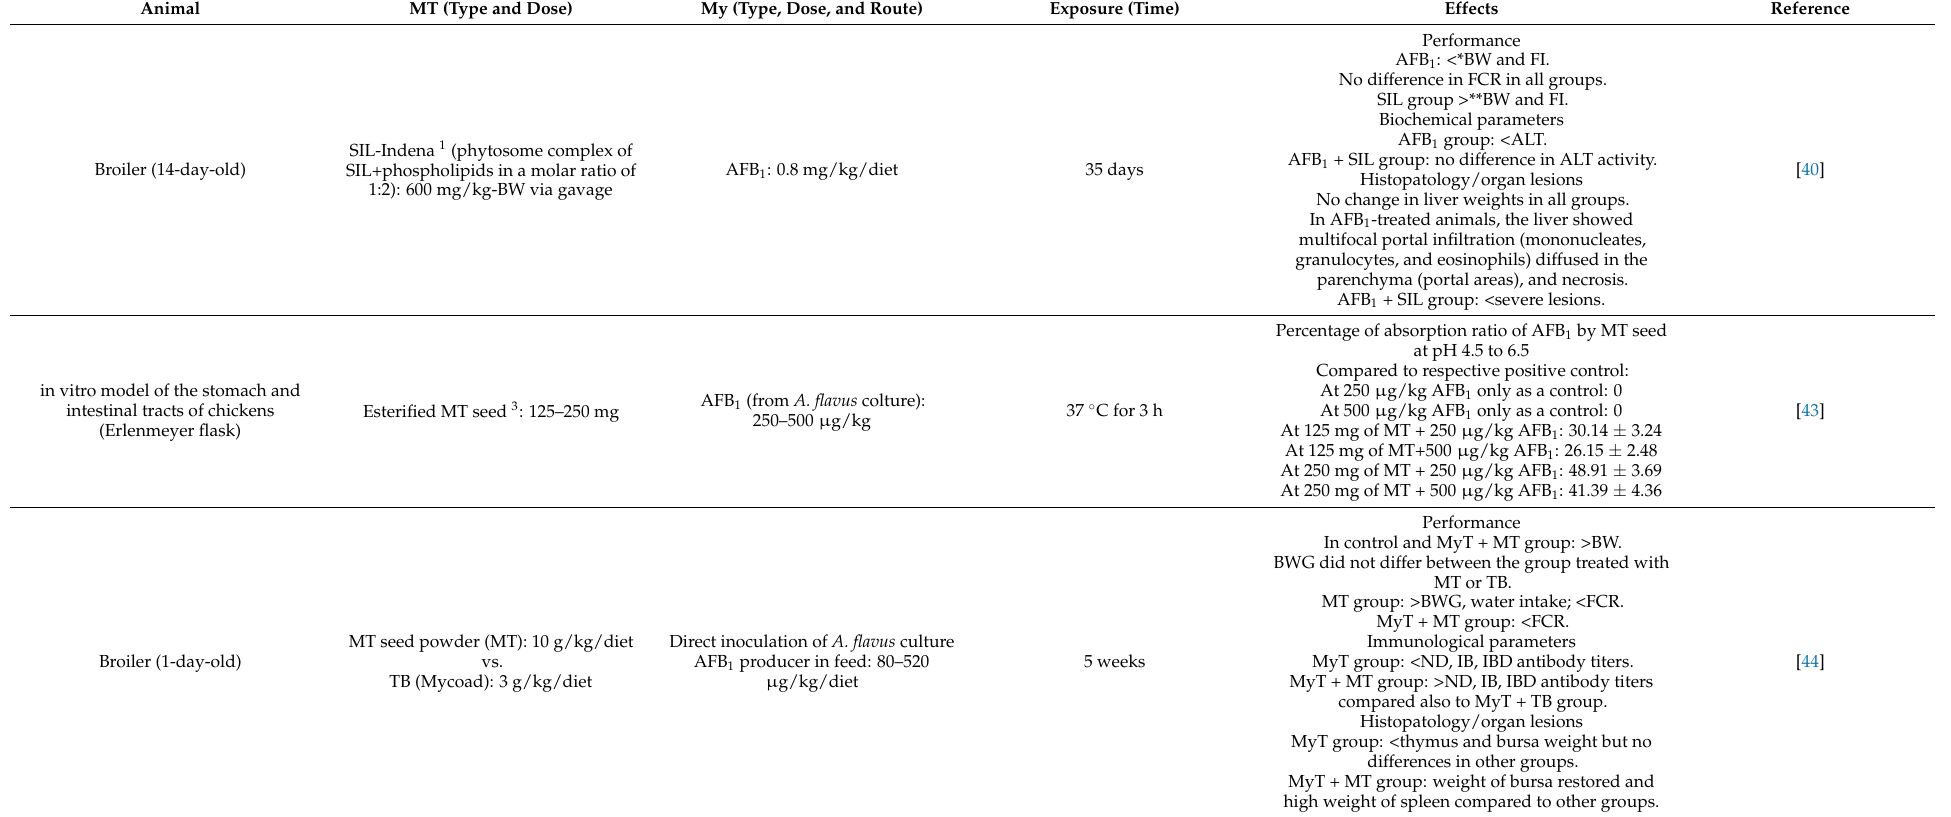
Table 1. Effects of milk thistle (MT) in chickens ( Gallus gallus ) poisoned by different types of mycotoxins (MyT). If not diversely reported in the section effects the results are referred to the control group without